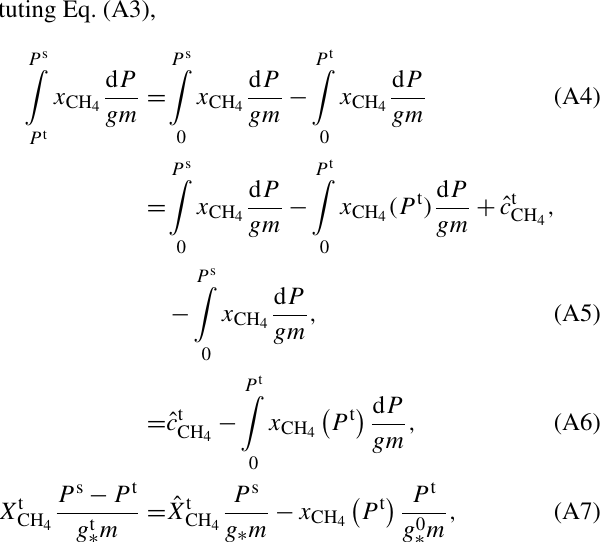
(cf. Wunch et al., CH 4